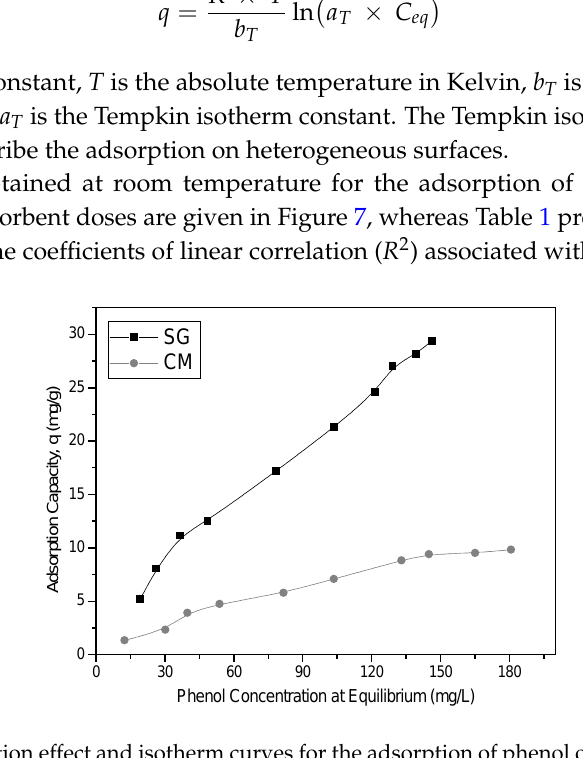
Figure 7. Concentration effect and isotherm curves for the adsorption of phenol on marine algae. Initial solution pH: 10 and masses of SG and CM are 40 mg and 100 mg, respectively.